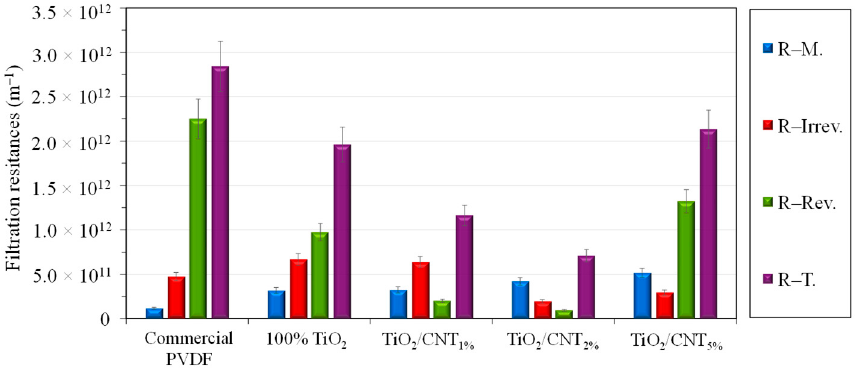
Figure 4. Calculated filtration resistances (when a transmembrane pressure of 0.1 MPa was applied). The lowest membrane resistance (R-M.) was calculated for the unmodified PVDF membrane (in accordance with its highest pure water flux), which significantly increased after coating with TiO 2 , and further increased with increasing CNT contents.